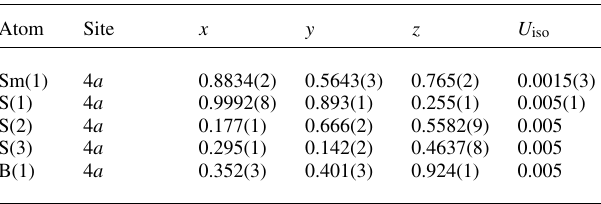
Table 1. Data collection and handling. Table 2. Atomic coordinates and displacement parameters (in Å 2 )